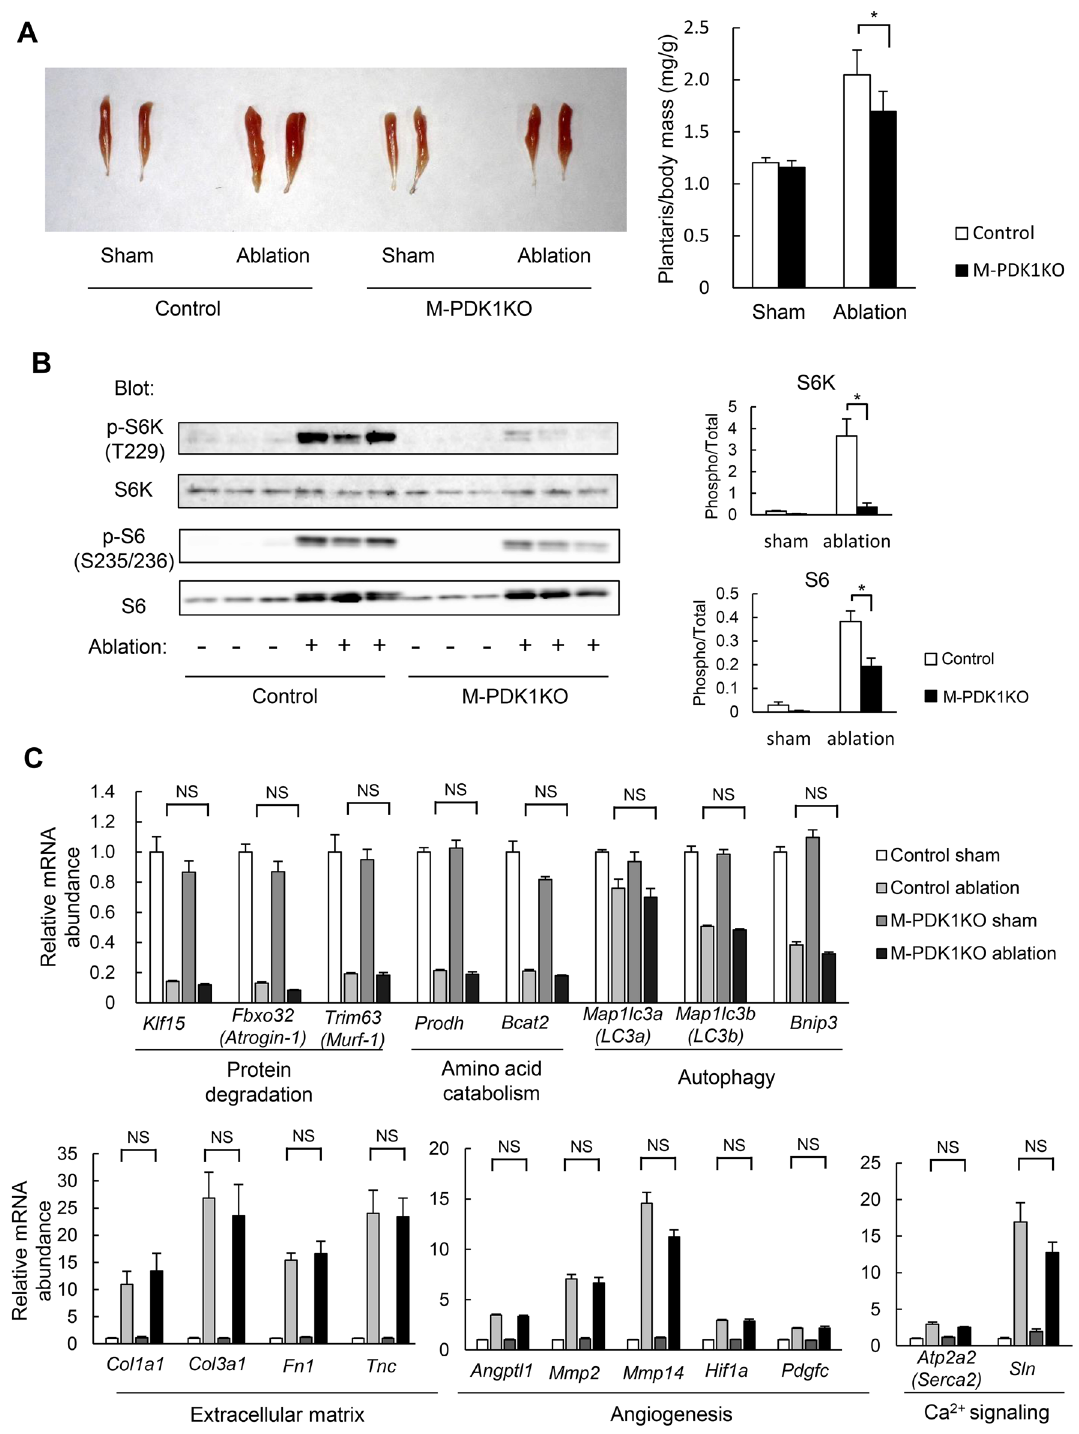
Figure 3. Impairment of exercise-induced muscle hypertrophy in M-PDK1KO mice. ( A ) Representative gross appearance as well as the mass ( n = 6 mice) of the plantaris muscle at 10 days after synergistic muscle ablation (or sham surgery) in control and M-PDK1KO mice at 12 weeks of age. ( B ) Immunoblot analysis of S6K and S6 abundance and phosphorylation in the plantaris muscle of mice treated as in ( A ). Each lane in the left panel corresponds to one mouse, and quantitative data are shown in the right panels. Each band was quantified with the use of the ImageQuant TL software. ( C ) Quantitative RT-PCR analysis of the indicated mRNAs in the plantaris muscle of mice treated as in ( A ) ( n = 4 mice). The amount of each mRNA in sham-operated control mice was assigned a value of 1. All quantitative data are means ± SEM. * P < 0.05, NS, not significant [one-way ANOVA followed by Tukey in ( A , B , C